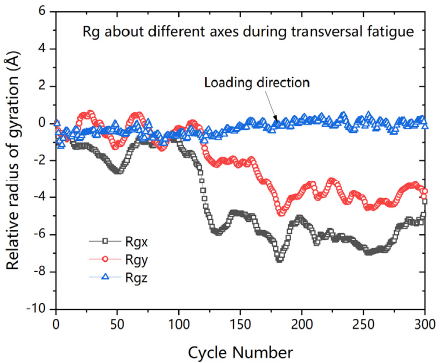
10 of 13 Figure 10. Mean-squared displacement of water molecules and epoxy resin molecules in the loading direction. The radius of gyration was a measure of the size of the group of atoms, and was computed as the square root of the R g 2 value in the fomula below: (cid:1844) (cid:3034)(cid:2870) = 1 (cid:1839) (cid:3533)(cid:1865) (cid:3036) ((cid:1870) (cid:3036) − (cid:1870) (cid:3030)(cid:3040) ) (cid:2870) (7) where M is the total mass of fracture and r cm is the center of mass position of the fracture. The x, y, and z components of the radius of the gyration tensor can be determined using the same fromula. This property indicates the level of deformation. To further clarify the results, the initial value of the radius of gyration was set to 0 and relative mean value of radius of gyration was employed to describe the structual change during the fatigue pro- cess. Figure 10 presents the evolution of the relative mean value of radius of gyration dur-